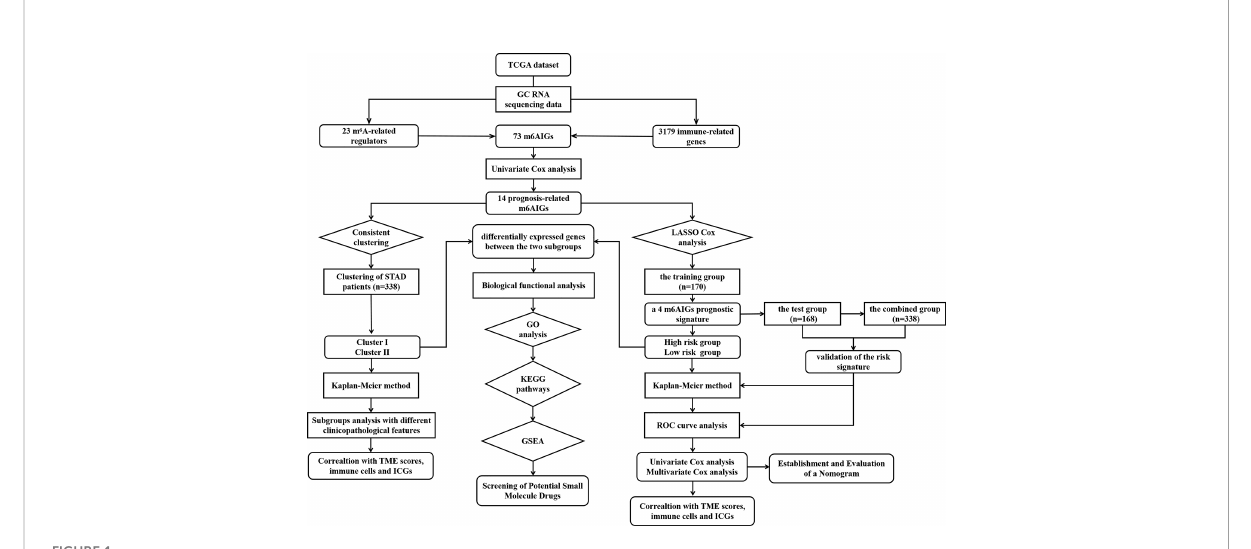
FIGURE 1 The fl ow chart of the